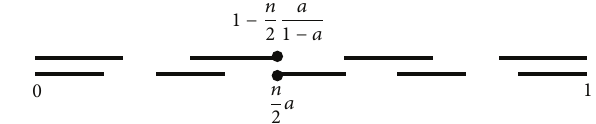
Figure 4: Special choice of a shift 𝑎 : (𝑛/2)𝑎 = 1 − (𝑛/2)(𝑎/(1 − 𝑎)) , even 𝑛 .